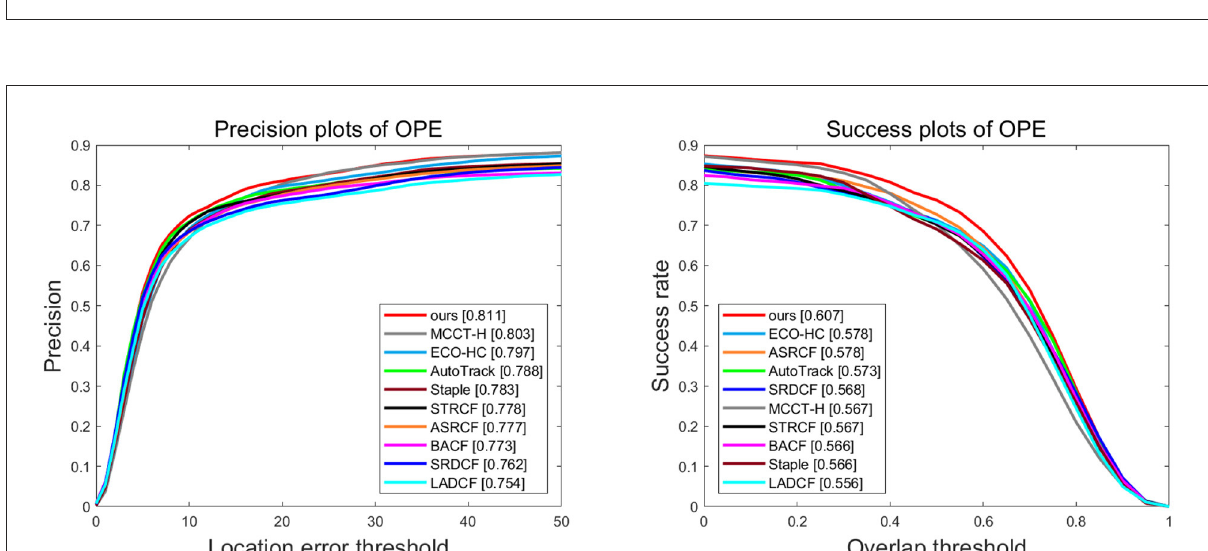
FIGURE1 Overall performance of ten trackers on UAV123. The legend of success plot represents the area under the curve score of each tracker. The legend of the precision plot refers to the threshold scores at 10 pixels.